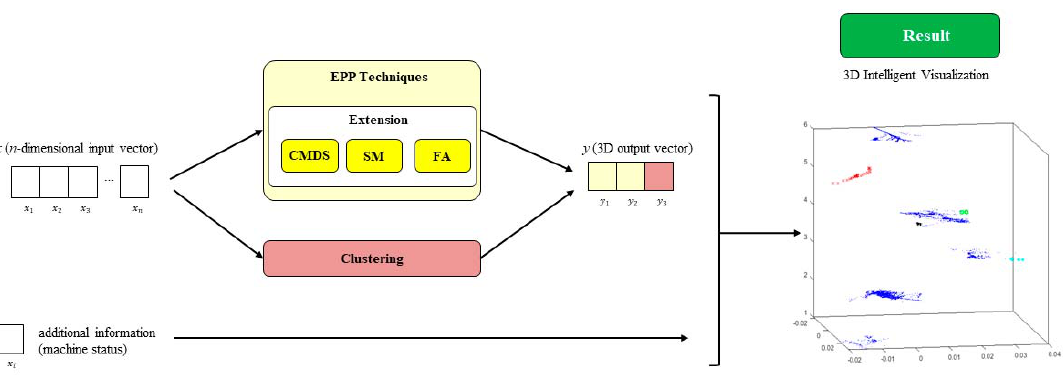
Figure 1. Process to obtain a HUEP.